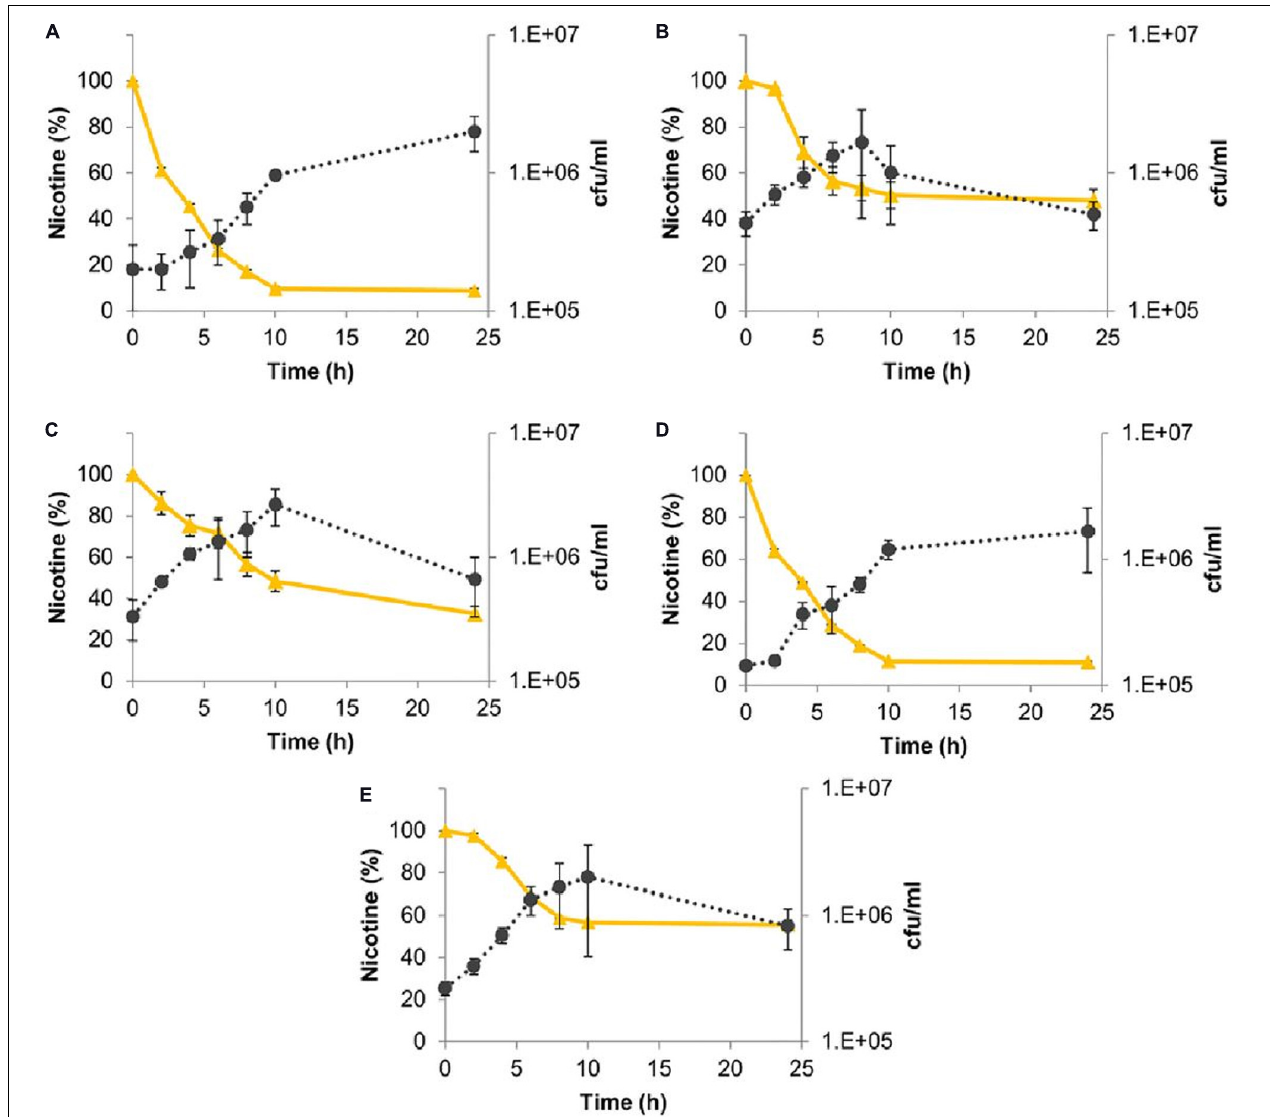
FIGURE 4 | Nicotine degradation by sunbirds’ gut bacterial isolates. (A) Methylorubrum populi (MK348790.1), (B) Chryseobacter gleum (MK348808.1), (C) Enterobacter hormaechei (MK348783.1), (D) Lactococcus lactis (MK348788.1), and (E) Kocuria palustris (MK348831.1). Nicotine percentage curves are in yellow, while the number of bacterial colonies per ml (cfu/ml) curves is in black. Results are presented as mean ±